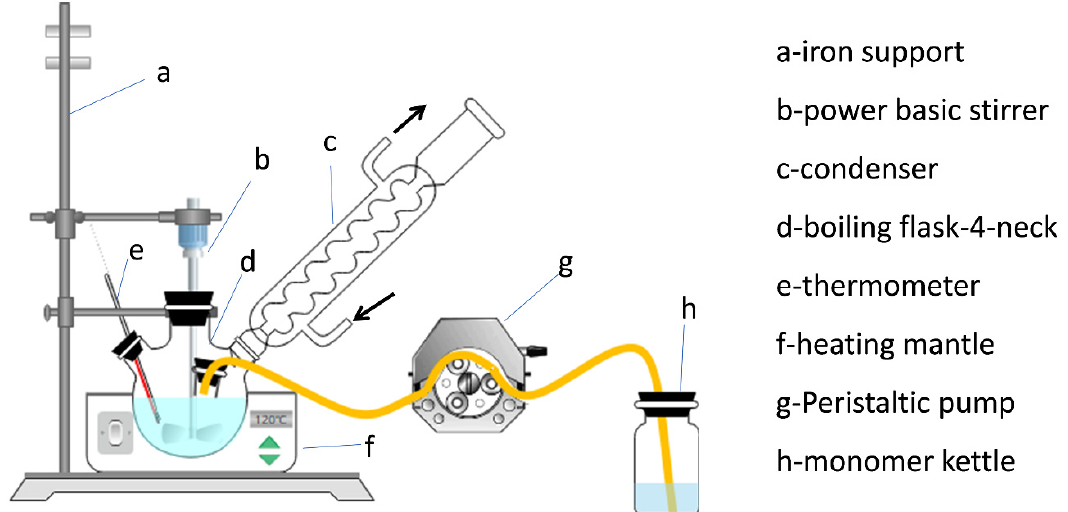
Figure 3. Schematic diagram of the experimental setup.